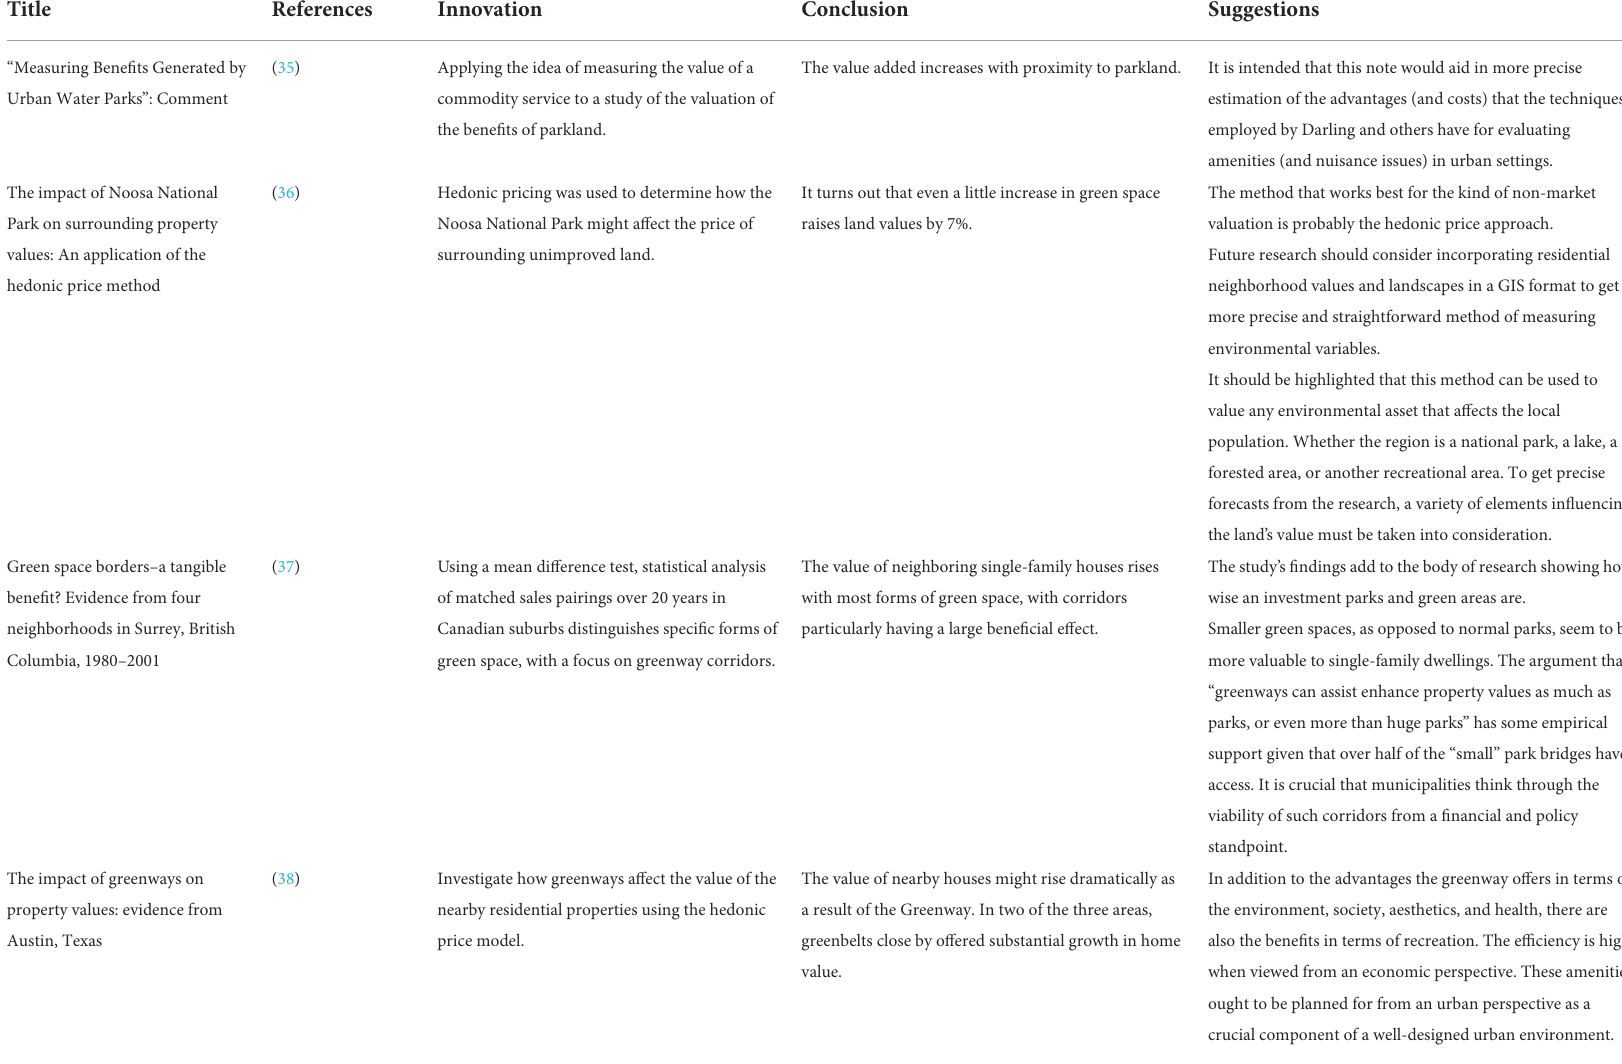
TABLE 5 Literature review of differences in the direction of impact of the same park green